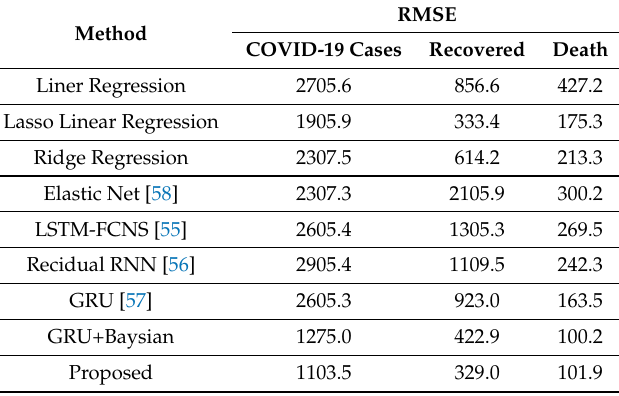
Table 3. Average root-mean-square error (RMSE) of the last 25 days’ prediction of numbers of active, recovered and death